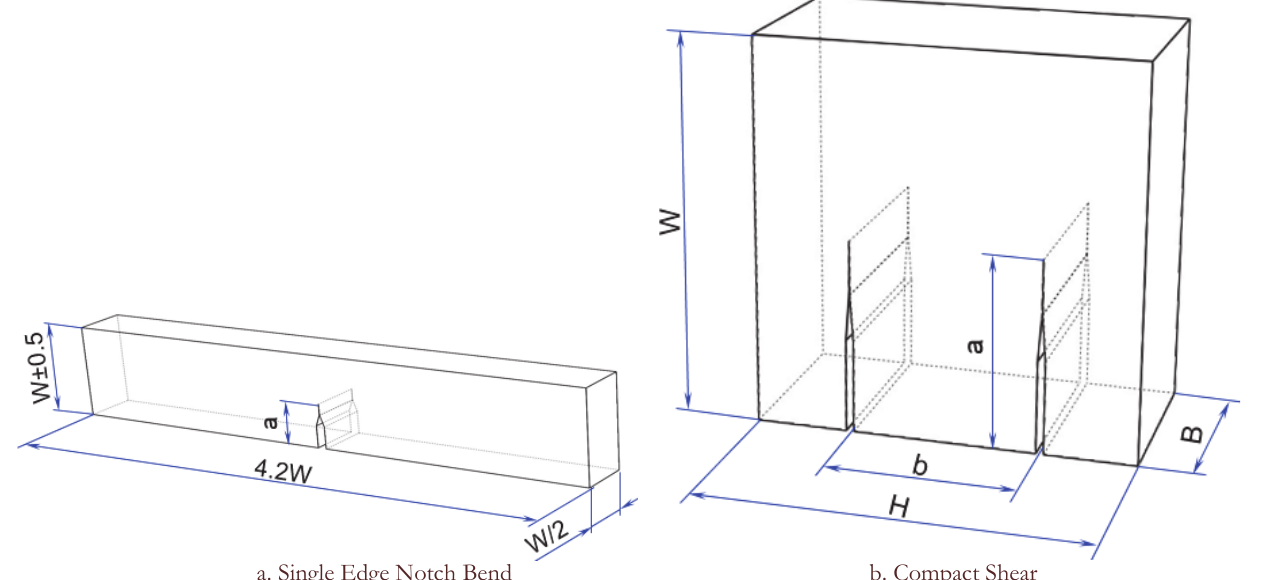
Figure 4: Test specimens for mode I and mode II fracture toughness determination.